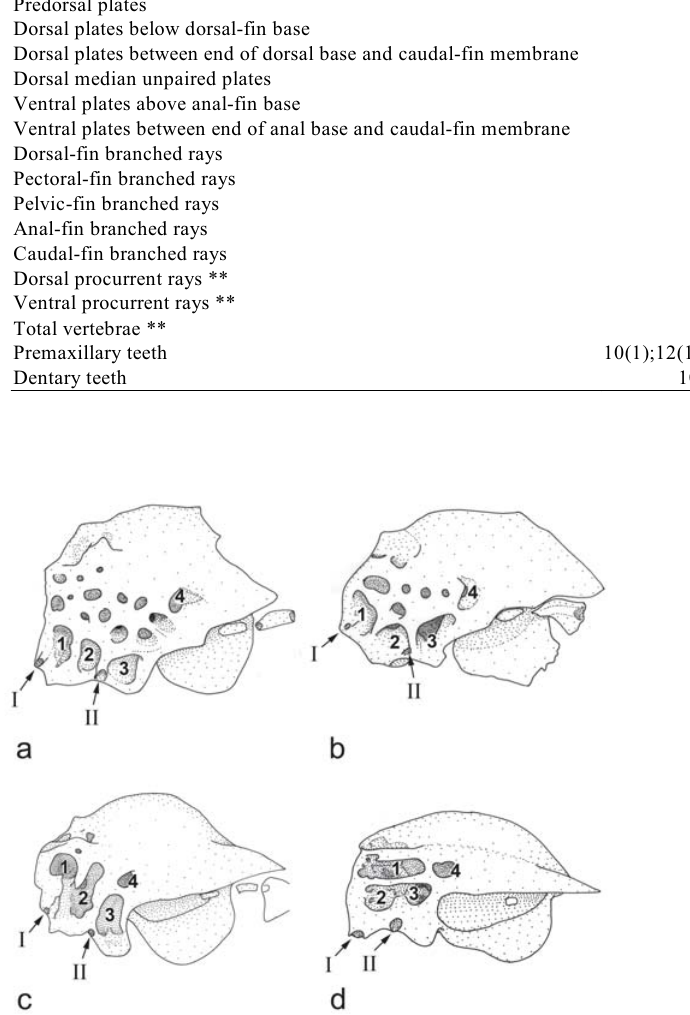
Fig. 7. Comparative morphology of the compound pterotic- supracleithrum-posttemporal, a) Schizolecis guntheri , LIRP 555, 38 mm SL;, b) Otothyropsis marapoama , Paratype LIRP 5641, 29.0 mm SL, c) Pseudotothyris obtusa , LIRP 525, 27.4 mm SL, and d) Otothyris lophophanes , MZUSP 80205, 22 mm SL. Numbers 1 to 4 correspond to homologous fenestrae. Arrows indicate the homologous pores of the lateral line sys- tem. (I) opening of the preopercular latero-sensory canal and (II) opening of the posterolateral latero-sensory canal.